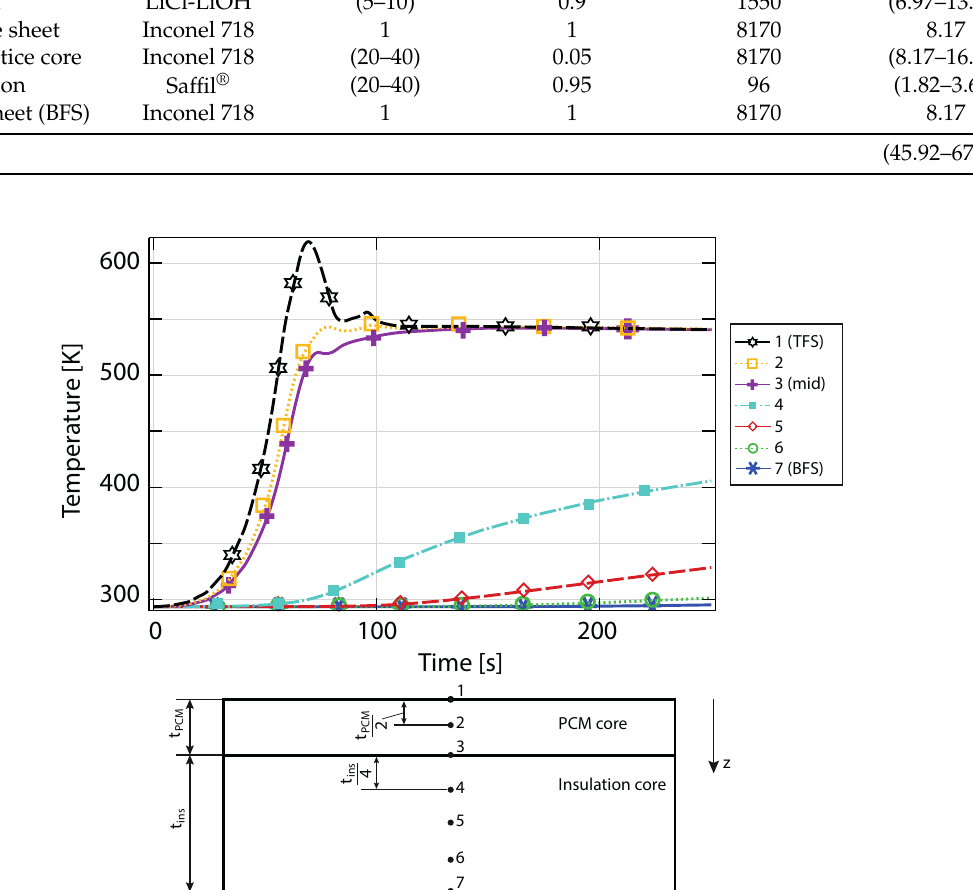
10mm, (cid:101) = 0.9, t c PCM ins